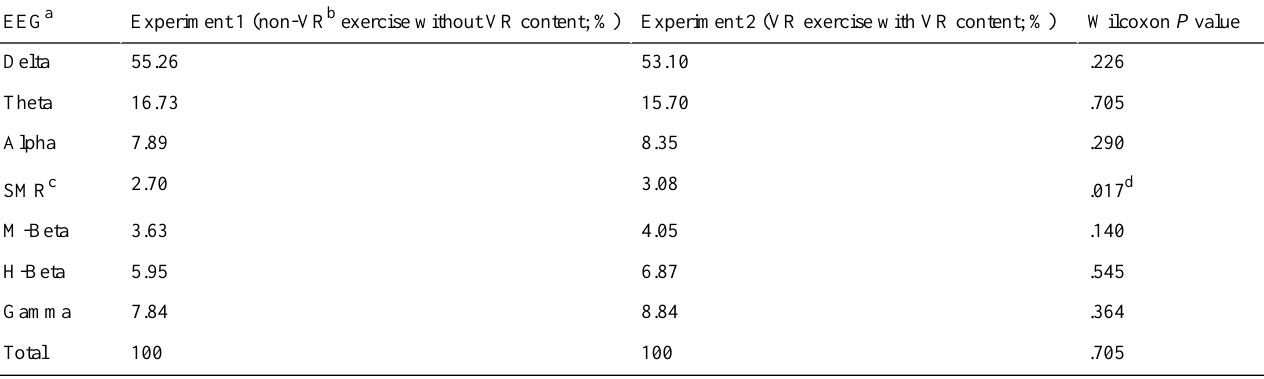
Table 3. EEG measurement in experiment 1 and experiment